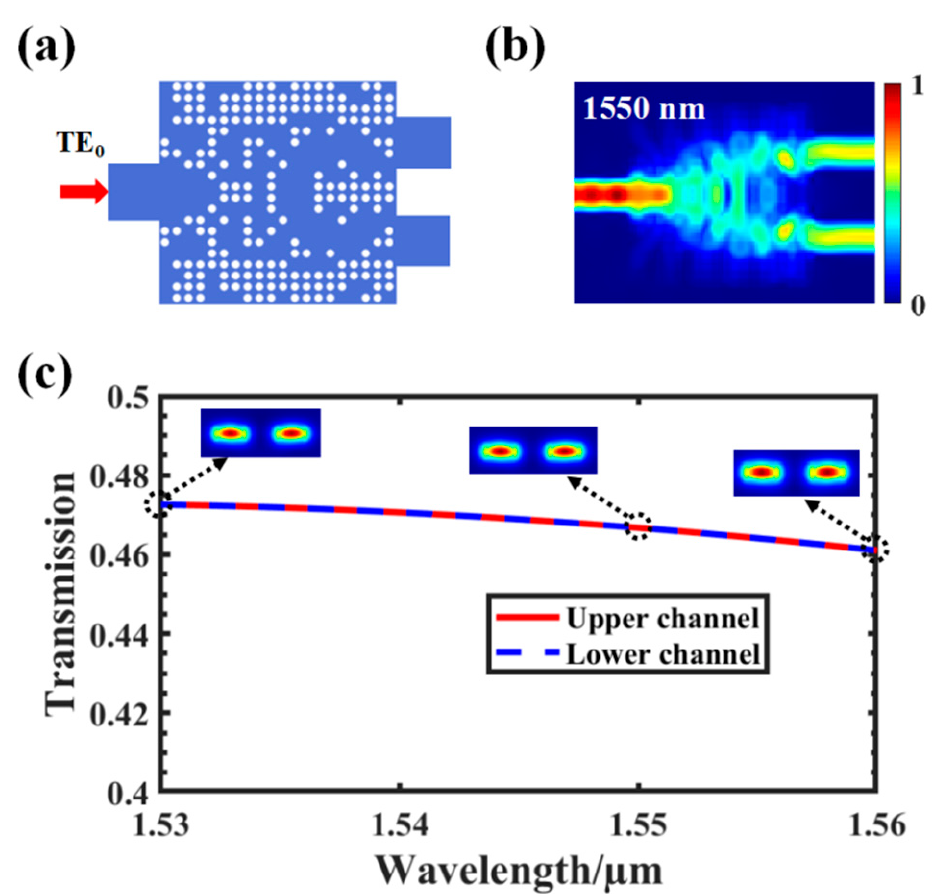
Figure 4. ( a ) Structure diagram of a 50:50 average power splitter; ( b ) light field distribution at 1550 nm of the upper and lower channels; ( c ) the TE 0 mode spectral transmission curves of the upper and lower channels in the wavelength range of 1530–1560 nm were simulated, and the cross-section mode profiles of the two output channels are plotted at different wavelengths.